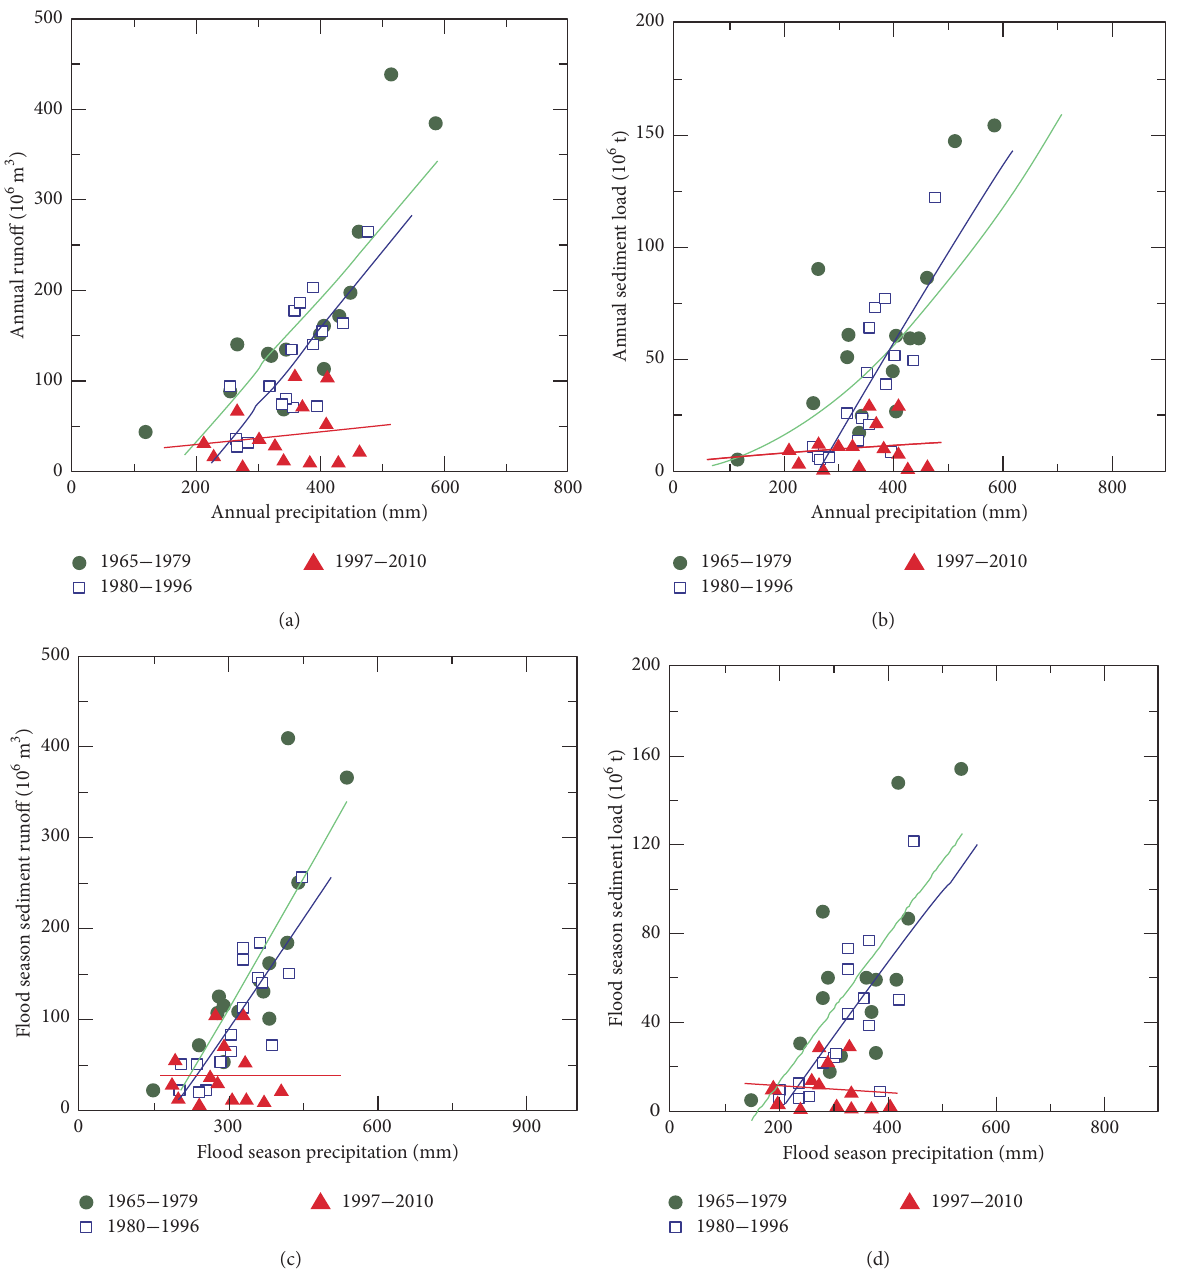
Figure 9: Correlation between annual and flood season runoff, sediment load, and precipitation in the catchment from 1965 to 2010 ((a), (b) relationship of annual runoff and sediment versus precipitation; (c), (d) relationship of flood season runoff and sediment load versus